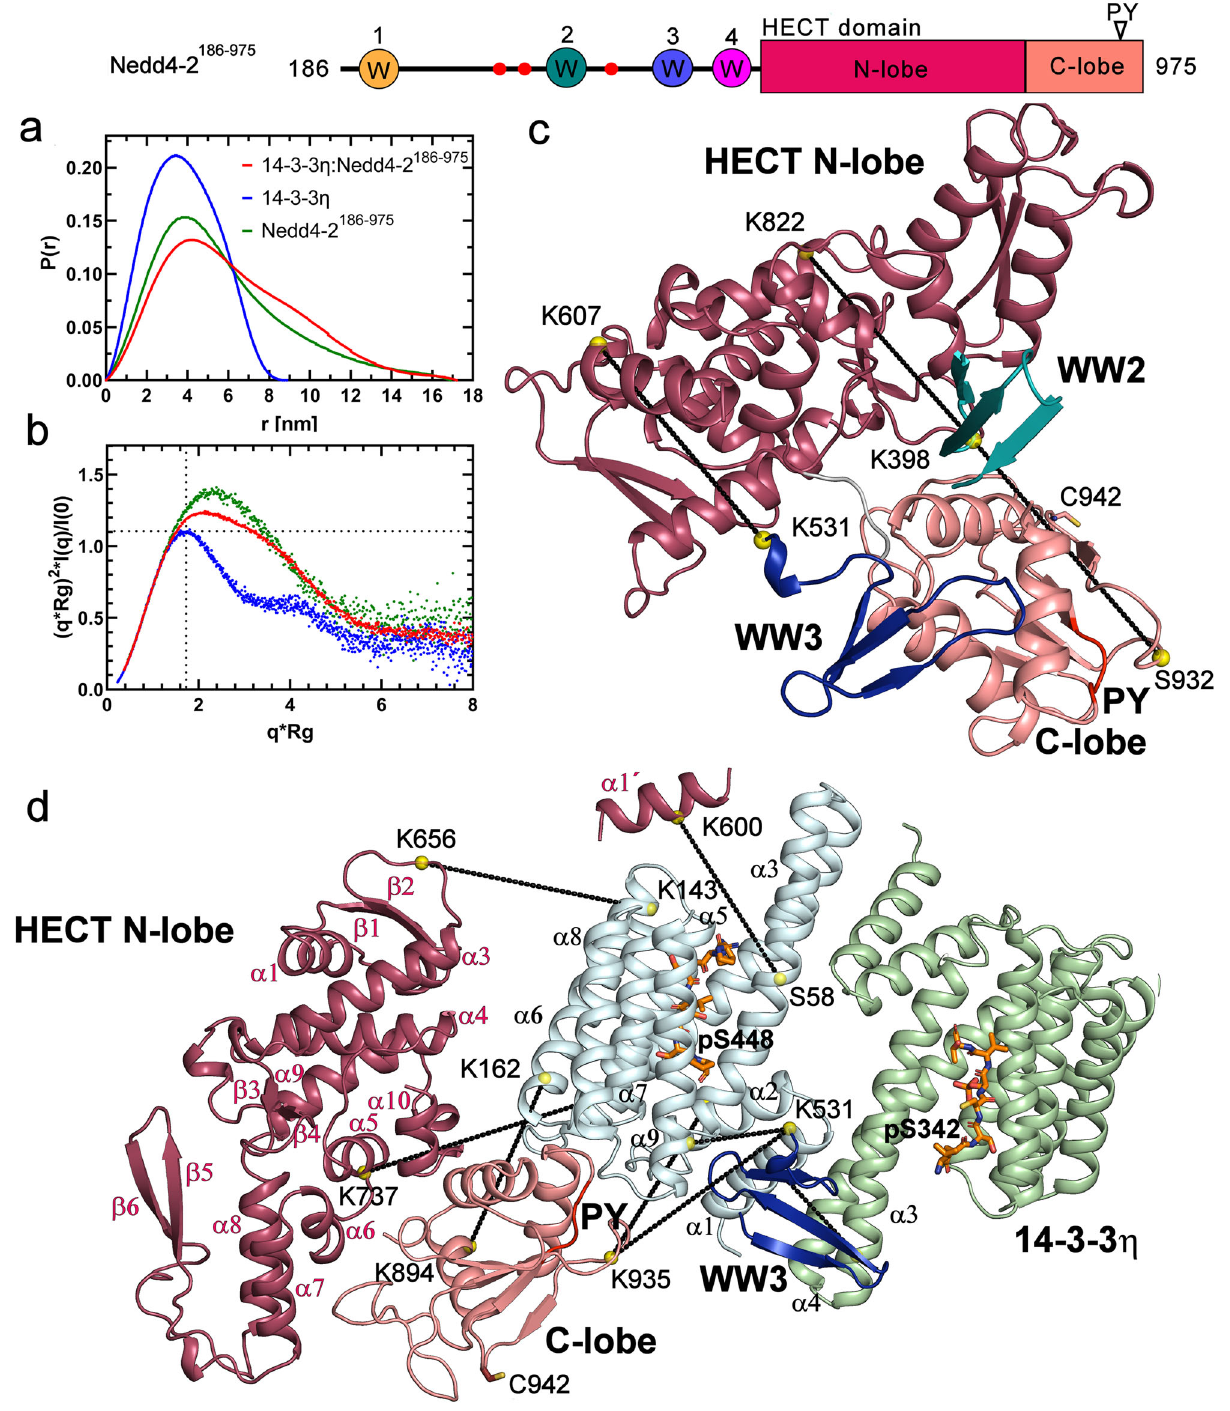
Fig. 7 SAXS-based structural modeling of the pNedd4-2 186 – 975 :14-3-3 η complex and pNedd4-2 186 – 975 . a Plot of the distance distribution functions P(r), with maximum particle dimensions ( D max ) of 169, 89 and 172 Å for Nedd4-2 186 – 975 , 14-3-3 η and the 14-3-3 η :pNedd4-2 186 – 975 complex, respectively. b Dimensionless Kratky plots are shown in green for Nedd4-2 186 – 975 , in blue for 14-3-3 η , and in red for the 14-3-3 η :pNedd4-2 186 – 975 complex. The dotted lines mark the value of 1.104 for sR g = 1.73, denoting the peak of a perfectly globular particle. c Crosslinked domains from the best-scoring CORAL model of Nedd4-2 186 – 975 . The full model is shown in Supplementary Fig. S5. d Crosslinked domains from the best-scoring CORAL model of the Nedd4-2 186 – 975 :14- 3-3 η complex. The full model is shown in Supplementary Fig. S6. The 14-3-3 η protomers are shown in pale green and pale cyan. In the HECT domain of Nedd4-2 186 – 975 , the N-lobe is indicated in raspberry and the C-lobe in salmon. WW1, WW2, WW3 and WW4 domains are indicated in yellow, teal, blue and magenta, respectively. Phosphorylated 14-3-3 binding motifs of Nedd4-2 are shown as orange sticks (PDB ID: 6ZBT and 6ZC9, this work). C α atoms of crosslinked residues are shown as yellow spheres. The PY motif (L 948 PPY 951 ) is shown in red, and the catalytic residue Cys 942 is shown as a stick. The elements in the HECT N-lobe secondary structure are numbered according to 81